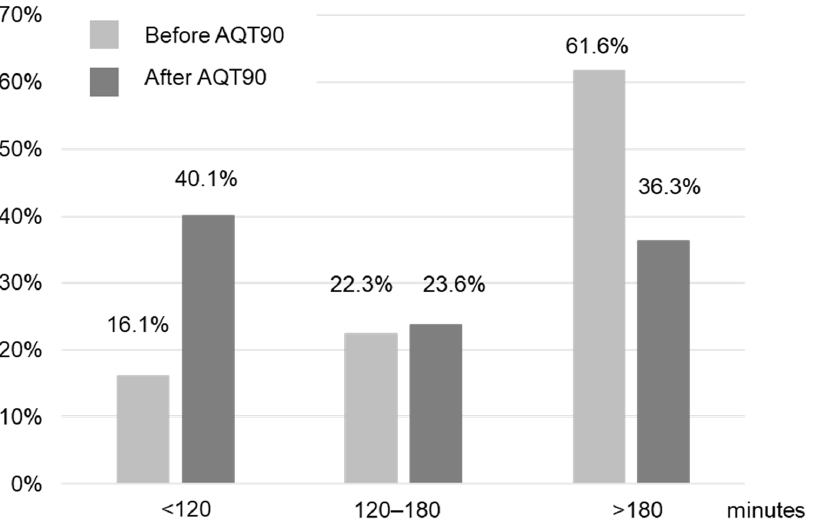
Figure 4. Frequency distribution of the patient length of stay per time period before and after the implementation of AQT90 in the emergency